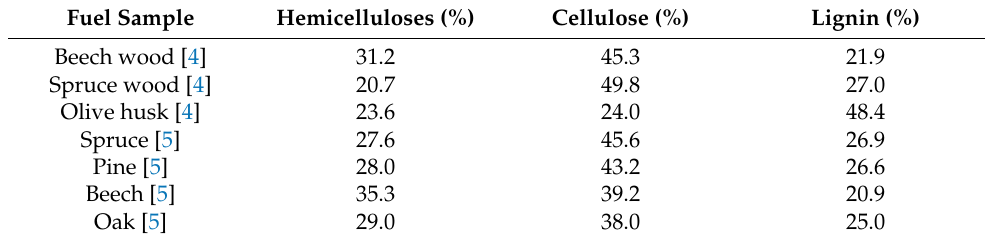
Table 1. Approximate chemical composition of European wood.